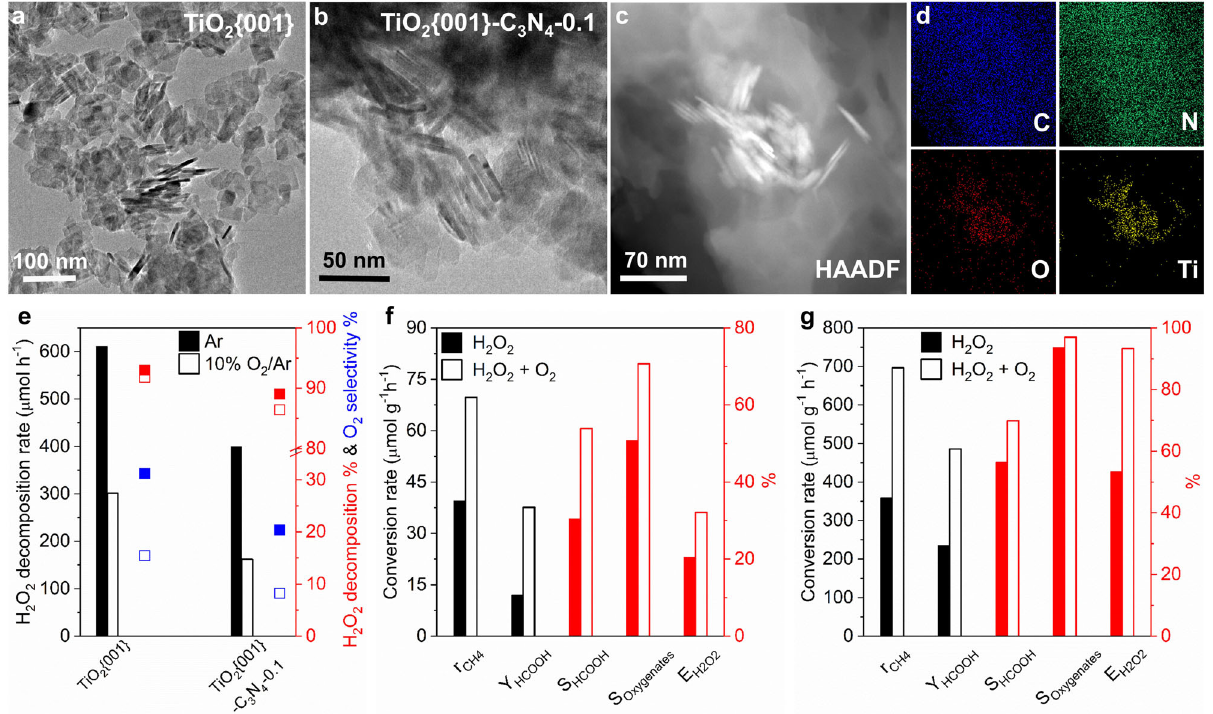
Fig. 1 | Photocatalysts and photocatalytic performance. a TEM image of TiO 2 {001}. b TEM, ( c ) HAADF and ( d ) element mapping images of TiO 2 {001}- C 3 N 4 − 0.1. e H 2 O 2 decomposition rate, H 2 O 2 decomposition and O 2 selectivity of photocatalytic H 2 O 2 decomposition over TiO 2 {001} and TiO 2 {001}-C 3 N 4 − 0.1 under the reaction condition of 165 μ L H 2 O 2 +20mL H 2 O in Ar or 10%O 2 /Ar. CH 4 con- versionrate(r CH4 ),yield(Y HCOOH )andselectivity(S HCOOH )offormicacid,selectivity of oxygenates(S Oxygenates ),and H 2 O 2 utilizationef fi ciency (E H2O2